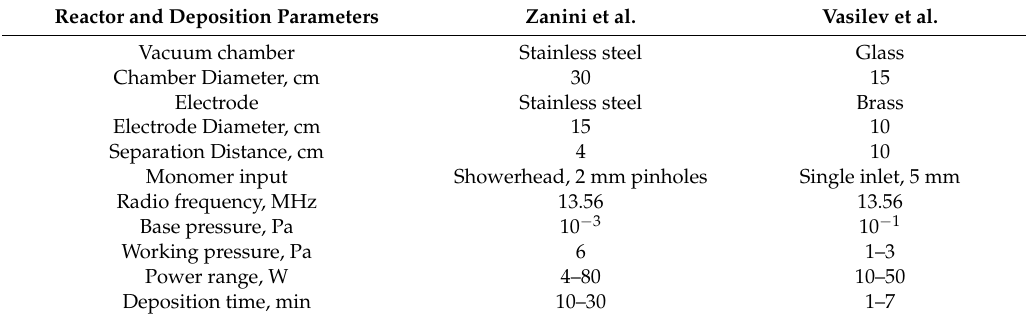
Figure 2. PPOx deposition conditions: ( a ) Effect of monomer chemistry on film thickness, ( b ) precursor flow rates on nitrogen content, ( c ) of plasma ignition powers on films stability for MeOx, EtOx and PiPOx. ( d ) PPEtOX Plasma deposition rate as a function of the Yasunda parameter is defined as the ratio between plasma power and monomer flow rate, in two different plasma reactors. Table 2. Plasma reactor specification and depositions condition ranges for the PPOx deposition studies conducted by Zanini et al. and Vasilev et